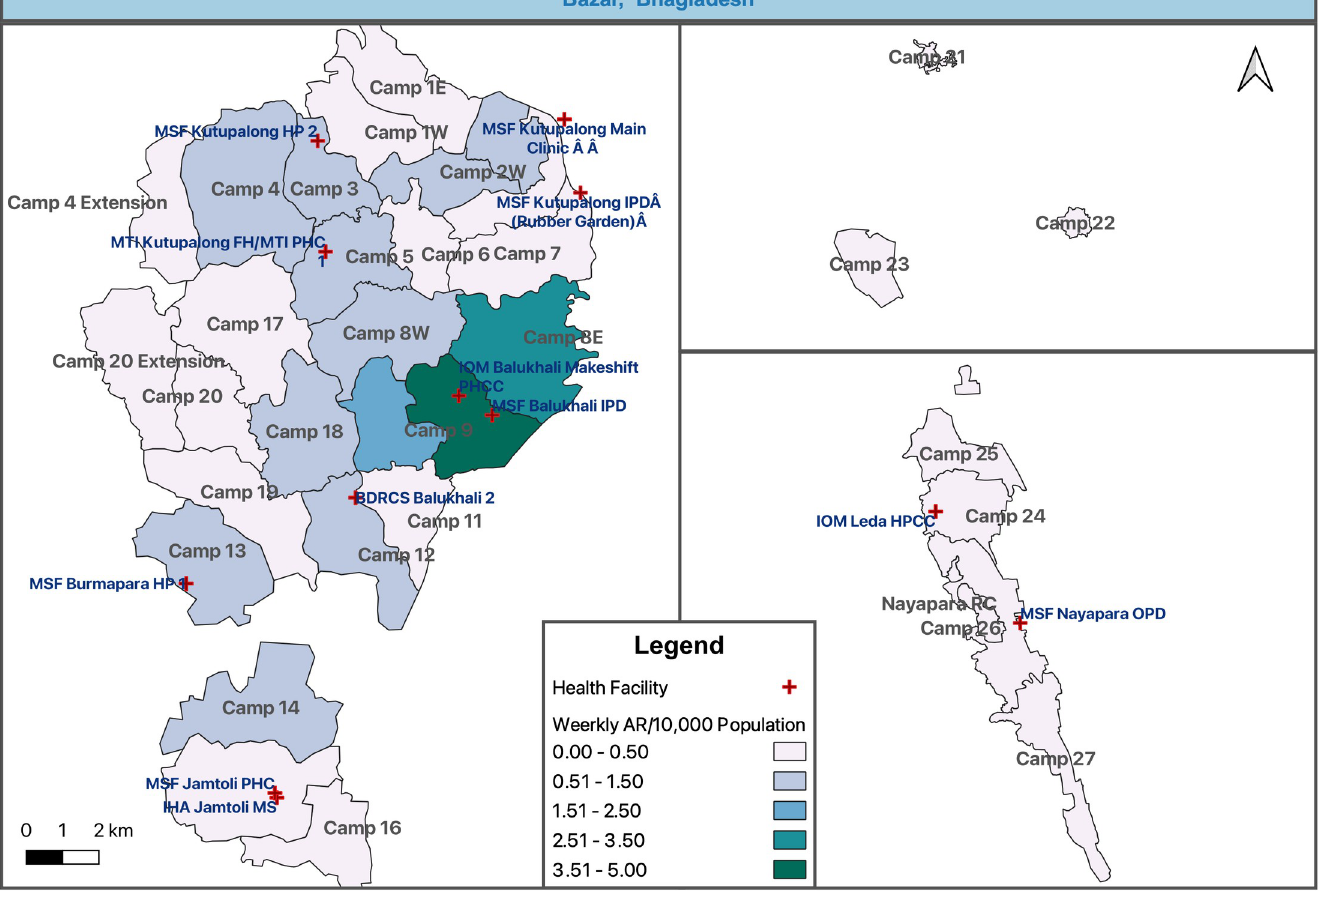
Fig 2. Map of AJS attack rate (per 10,000 population) reported through enhanced epidemiological surveillance strategy between 28 February and 26 March 2018 in the Rohingya refugee camps and locations of reporting health facilities in Cox’s Bazar, Bangladesh © 2021 by Md Khadimul Anam Mazhar is licensed under CC BY